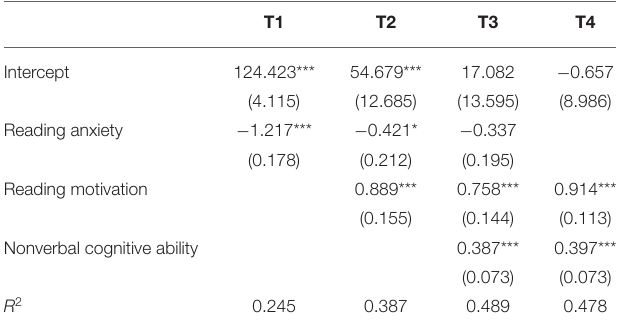
TABLE 5 | Taxonomy of models examining the relation between Math Fluency, math and reading anxiety, math motivation, and nonverbal cognitive ability ( n = 146).